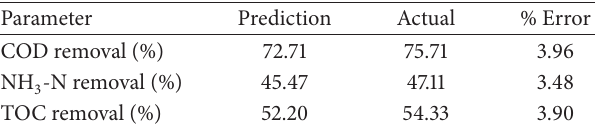
Table 3: Model prediction and actual